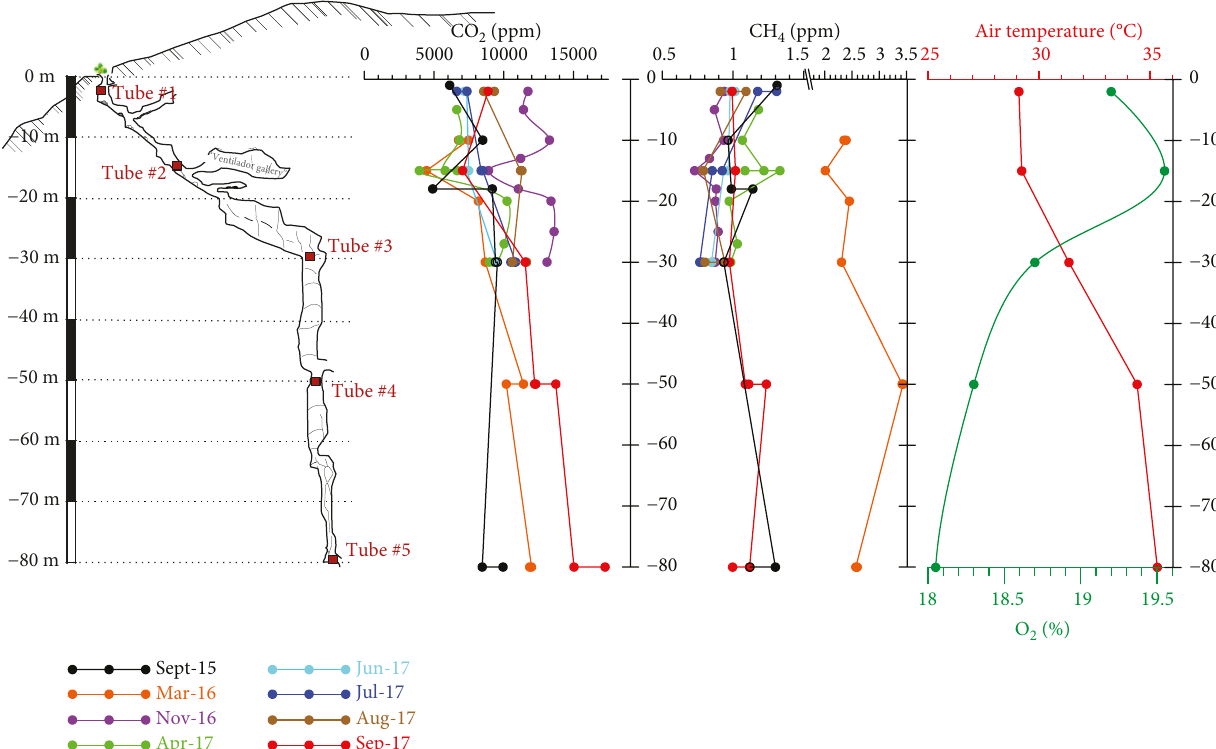
Figure 5: Spatiotemporal evolution of temperature and gaseous composition of cave air (CO